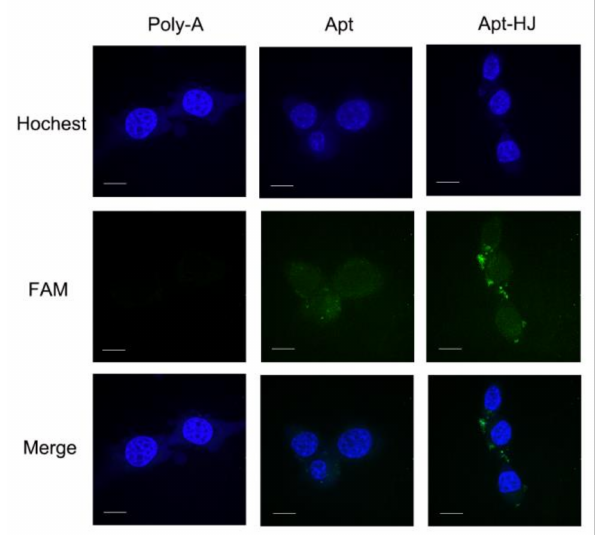
Figure 7. Confocal microscopic images of CT26 cells treated with FAM-labeled poly-A DNA, PD-L1 Apt, or Apt-HJ. The cell nuclei were stained blue with Hoechst. Scale bar: 10 µ